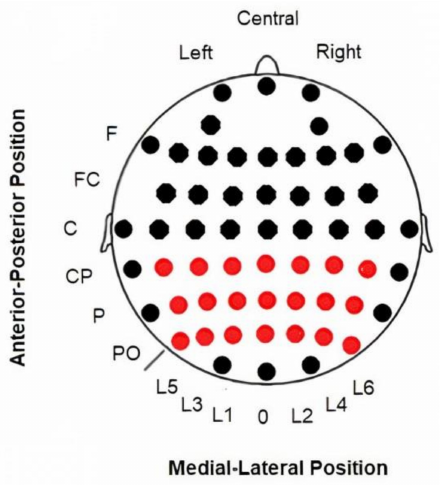
Figure 1. Electrode matrix selected to analyze spectral